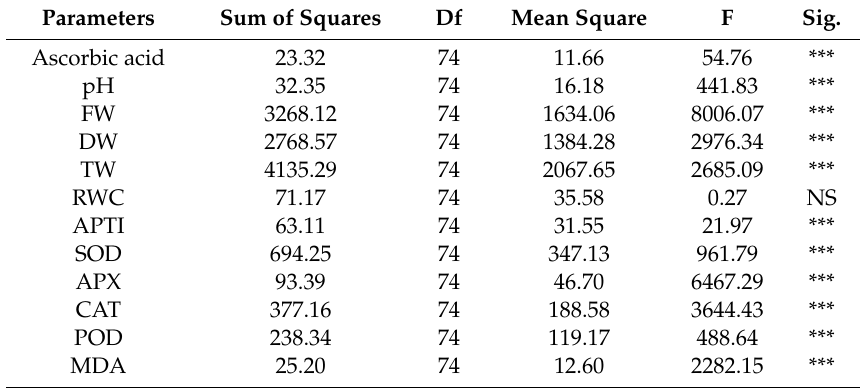
Table 2. ANOVA Summary of APTI related parameters and antioxidant enzymes at three experimental sites of P.